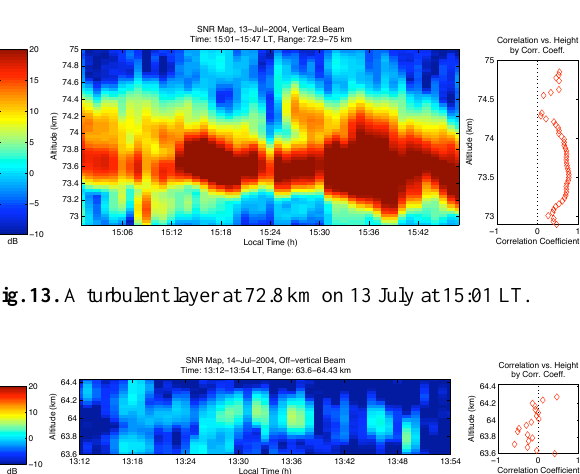
Fig. 12. A thin sheet at 69.6 km on May 28 at 10:40 LT.